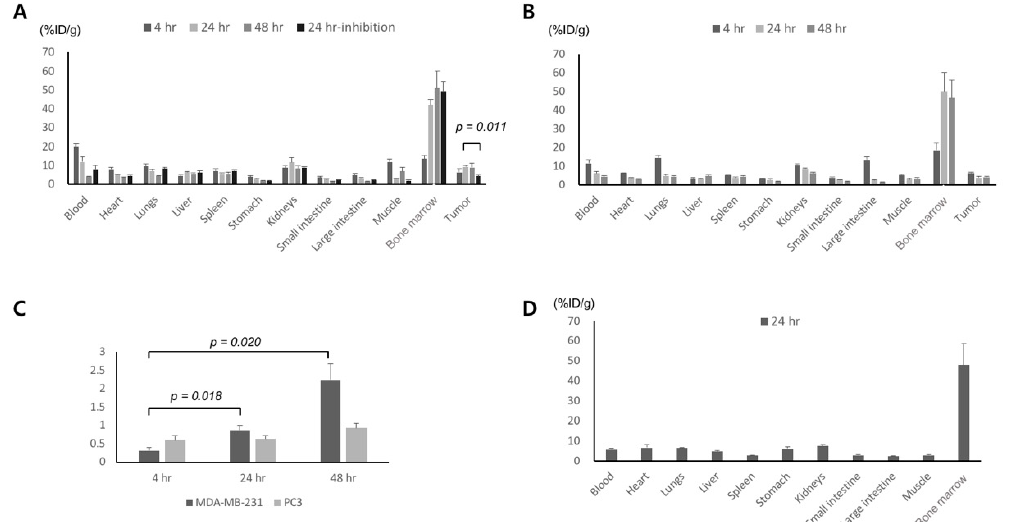
Figure 3. The biodistribution of Zr-89 ATPS mAb at 4, 24, and 48 h in mice bearing MDA-MB-231 tumors ( A ) and PC3 tumors ( B ). Uptake of Zr-89 ATPS mAb was inhibited by unlabeled ATPS mAb at 24 h for MDA-MB-231 tumors. Tumor -to-blood ratio of Zr-89 ATPS mAb ( C ). The biodistribution of Zr-89 oxalate at 24 h in wild-type mice ( D ). ATPS, adenosine triphosphate synthase; mAb, monoclonal antibody. Error bars = standard errors. Arrows indicate tumors.